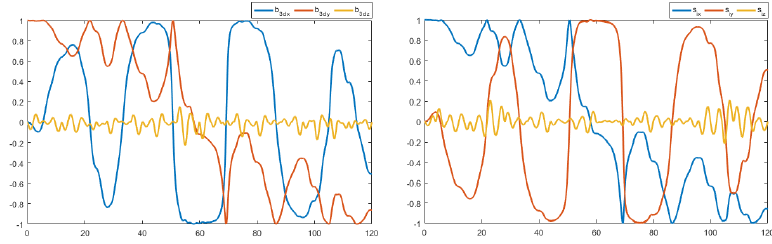
Figure 17. The pointing and thrust directions of the flight in terrain